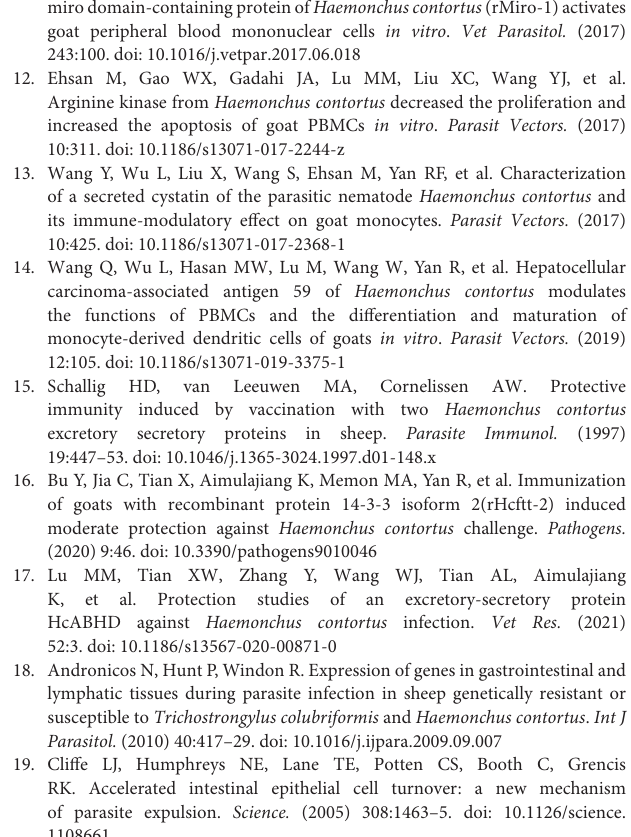
Supplementary Figure 1 | Electrophoresis analysis (SDS–PAGE) of the purification of rHc8 protein. Protein sample was clearly displayed by Coomassie brilliant blue R250 on 12% of polyacrylamide gel. M showed standard protein ladder; Lane 1 showed purified recombinant Hc8. Supplementary Figure 2 | ELISA analysis of specific antibody titer anti-rHc8 protein. Normal goat serums were utilized as negative controls. The cut-off values (0.41) are shown with a dotted line. Supplementary Figure 3 | Original picture of Supplementary Figure 1 . Supplementary Table 1 | Adult worm burden at necropsy and Fecal egg counts